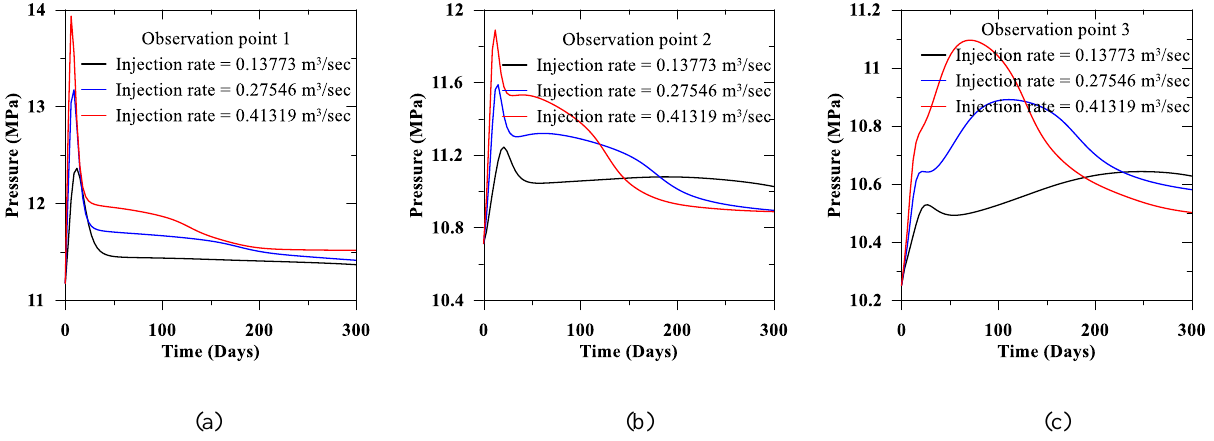
Figure 4. Injection rate effect on the pressure distribution in observation points ( a – c ).